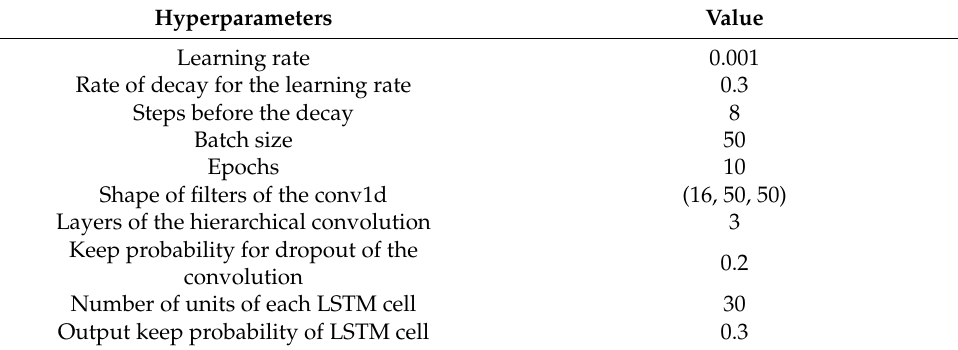
Table 4. Hyperparameters of the